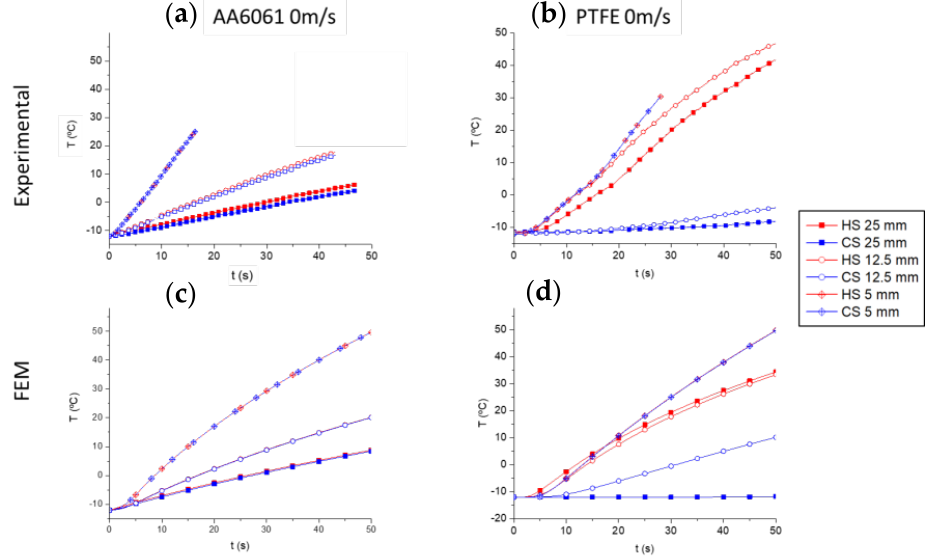
Figure 13. Height of samples and ratio of heated area vs. heating area; ( a ) 25 mm, ( b ) 12.5 mm and ( c ) 5 mm. The heating elements are represented by the grey bars. The different specimen sizes were characterized at 10.9 W and 0 m/s.